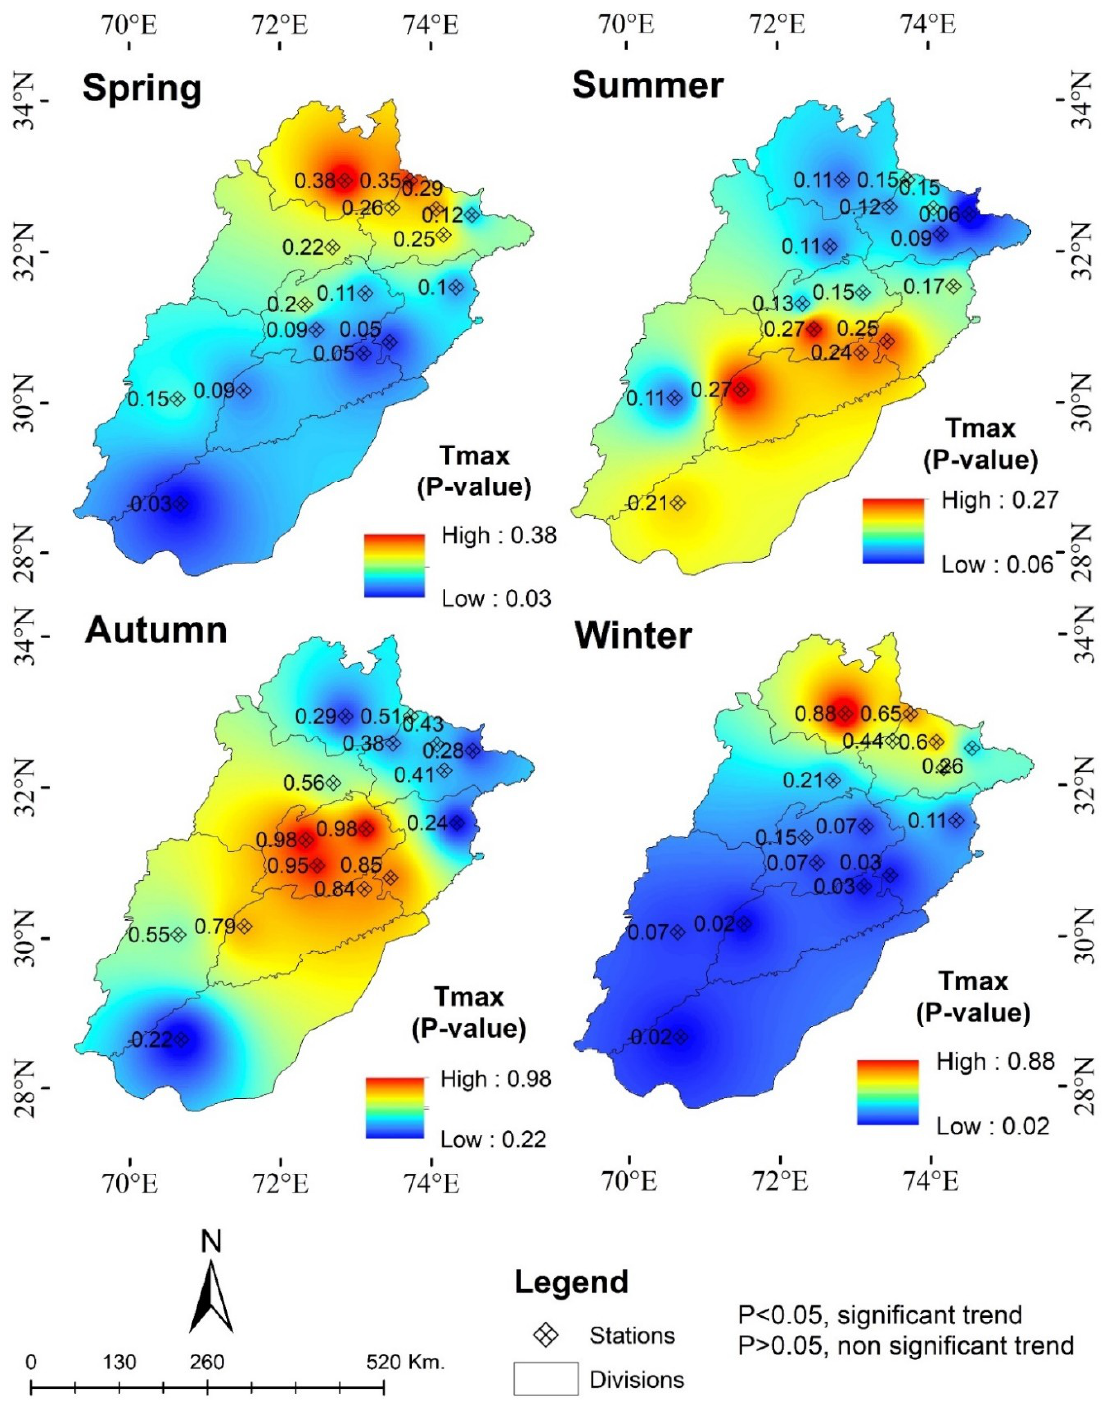
Figure 3. Seasonal p -values and the trends in T max (°C) of the 16 stations of Punjab, Pakistan, over the period 1979–2014.